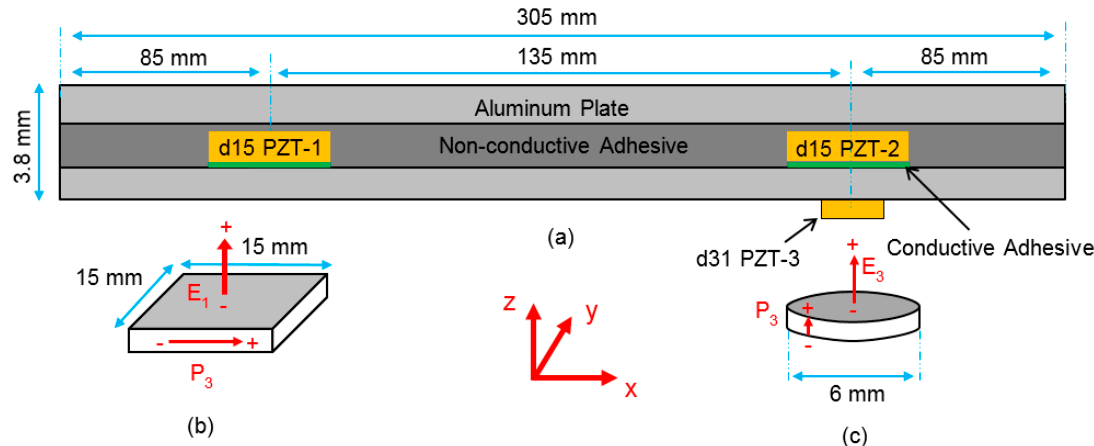
Figure 2. Schematic diagram of laminate specimen with two d15 lead zirconate titanate (PZT) transducers (15 mm × 15 mm × 1 mm) embedded in the bondline and d31 PZT sensor (6 mm × 0.25 mm) mounted on the surface of the bottom aluminum sheet.